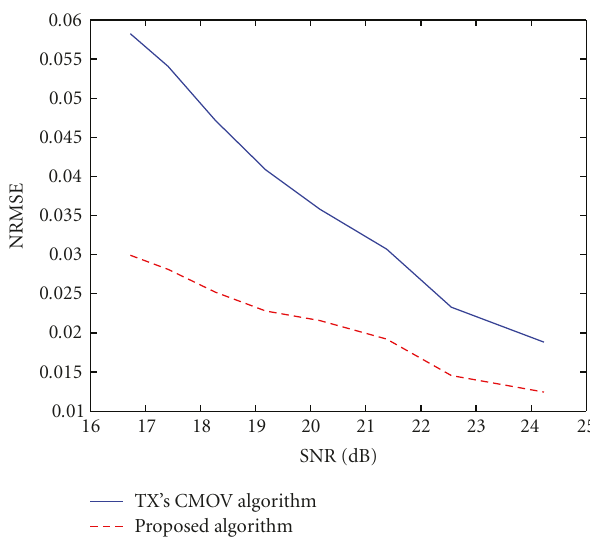
Figure 3: SNR and channel estimation NRMSE for colored